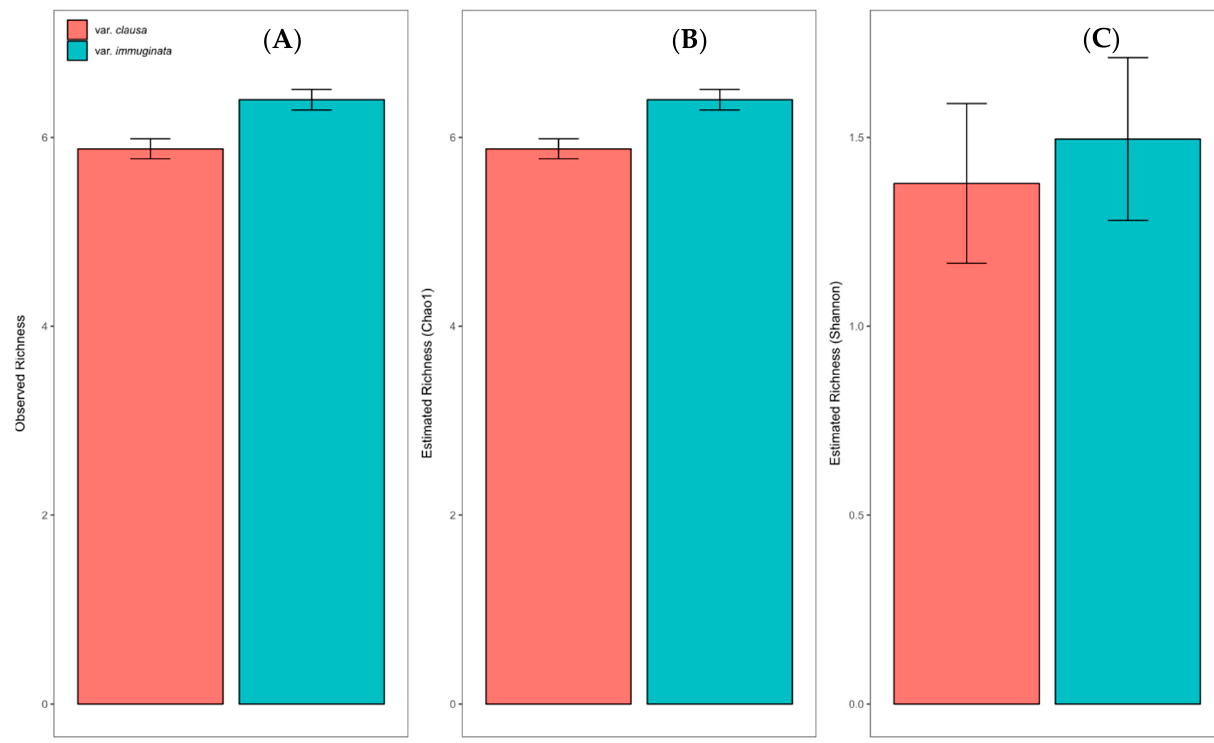
Figure A1. Average alpha diversity per tree by variety ( n = 25 per variety) ± SE. Alpha diversity was assessed as observed values ( A ), Chao1 ( B ), and the Shannon index ( C ).